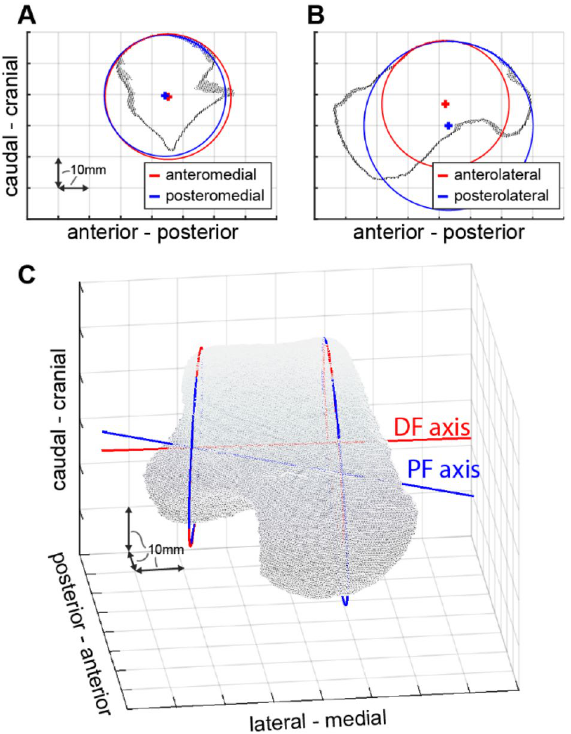
Figure 5. Axis determination based on morphology. ( A , B ) Section through the medial and lateral profile of the talar trochlea of Participant 3. Circles were fitted to each anterior and posterior part. ( C ) Corresponding centres were connected and resulted in the axis for dorsi- and plantarflexion. In this example, DF axis was inclined 1.2° and deviated 85.4° whereas PF axis was inclined − 13.2° and deviated